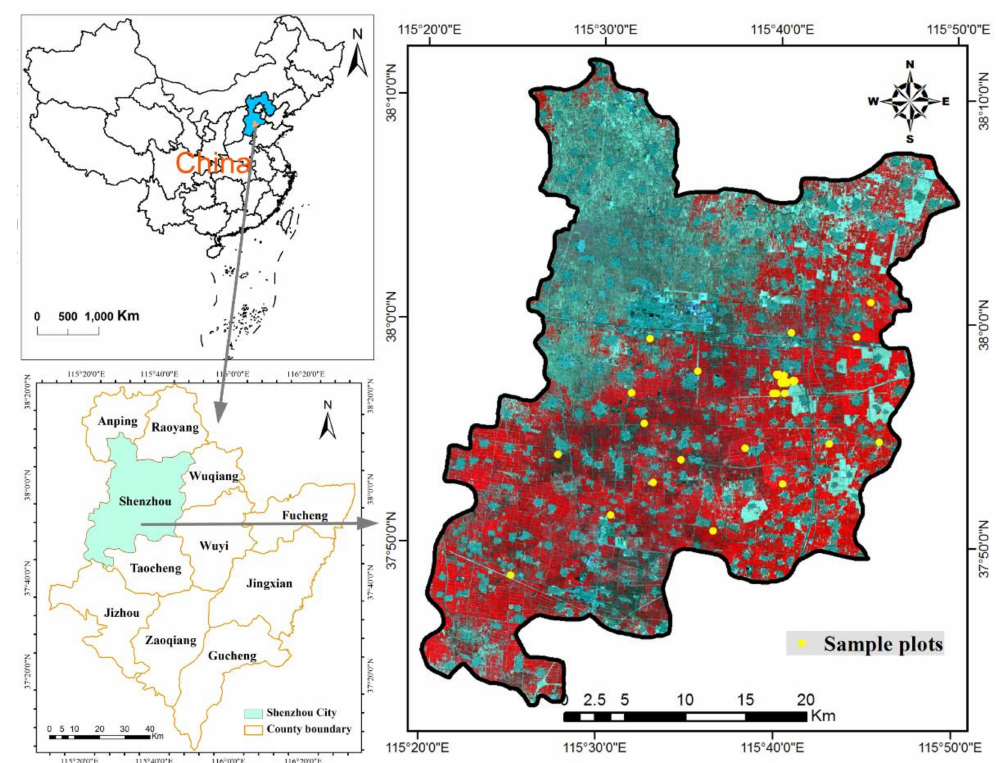
Figure 1. Location of the study area (GF-1 imagery displayed in this figure with false color composite: R = Near Infrared, G = red, B =